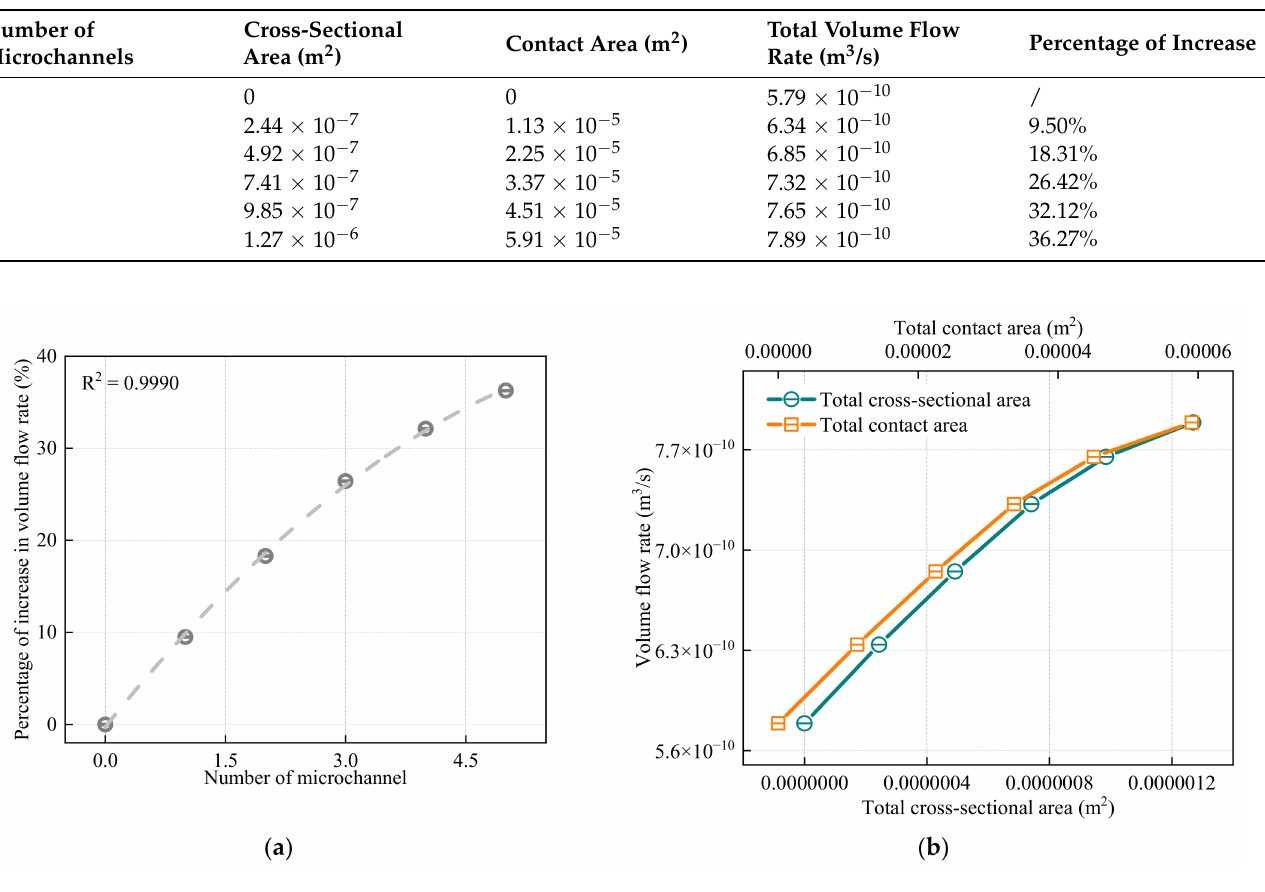
Figure 16. ( a ) Percentage of increase in the volume flow rate vs. number of microchannels, and ( b ) effect of increasing number of microchannels on the volume flow